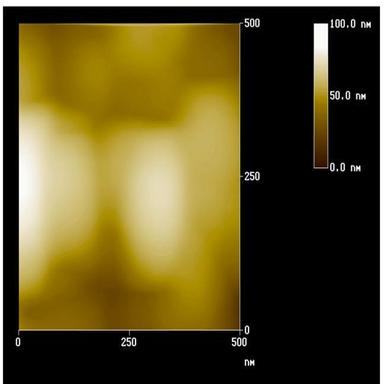
Larger (a) and smaller (b) length-scale AFM images of typical samples of G1 sol-gel silica showing the pore-scale morphology of the materials and the typical constituent particle size.